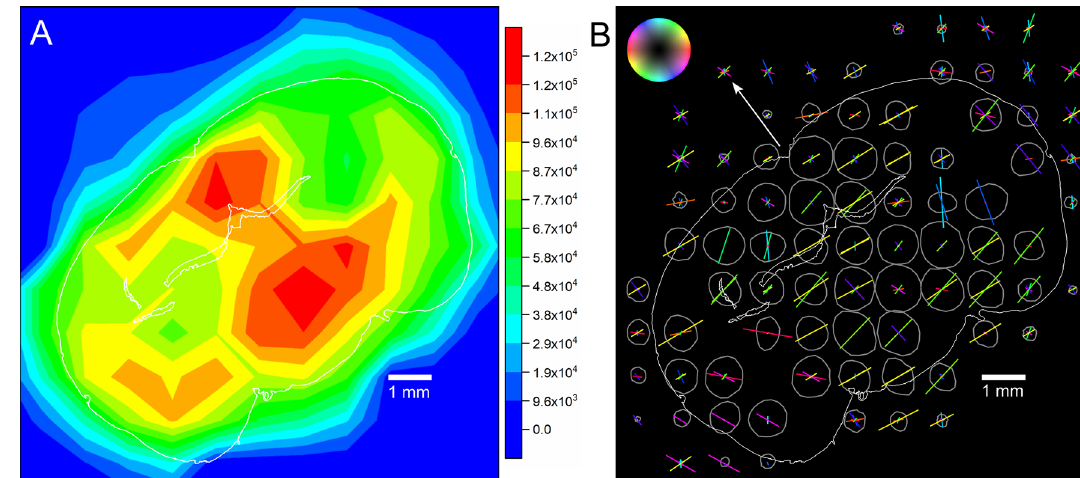
Figure 3. ( A ) 2D contour map of the integrated SANS intensity in the Porod regime or dark-field map. The color bar on the right side quantifies the scattering intensity. The obtained map is divided into following symmetrical regions. α: strong intensity region (red, orange), located in the caudal interhemispheric area; β: intermediate intensity region (faded orange and yellow), extending to both hemispheres; γ: the cranial interhemispheric area dominated by the callosal commissure, elongated towards the left hemisphere; ζ and η: low intensity regions (green), distributed over the cortical periphery and subcortical nuclei of each hemisphere, respectively. ( B ) Scattering intensity distribution profile and orientation map of the nerve fibers, as obtained from SANS intensity in the Porod regime. The colors of the bars correspond to the in-plane direction of the fibers according to the color legend on top left, while the length of the bars reflect the peak prominence in the scattering intensity profiles (gray ellipsoids). The white peripheral line indicates the silhouette of the brain section. The white arrow points to the top side of the brain.